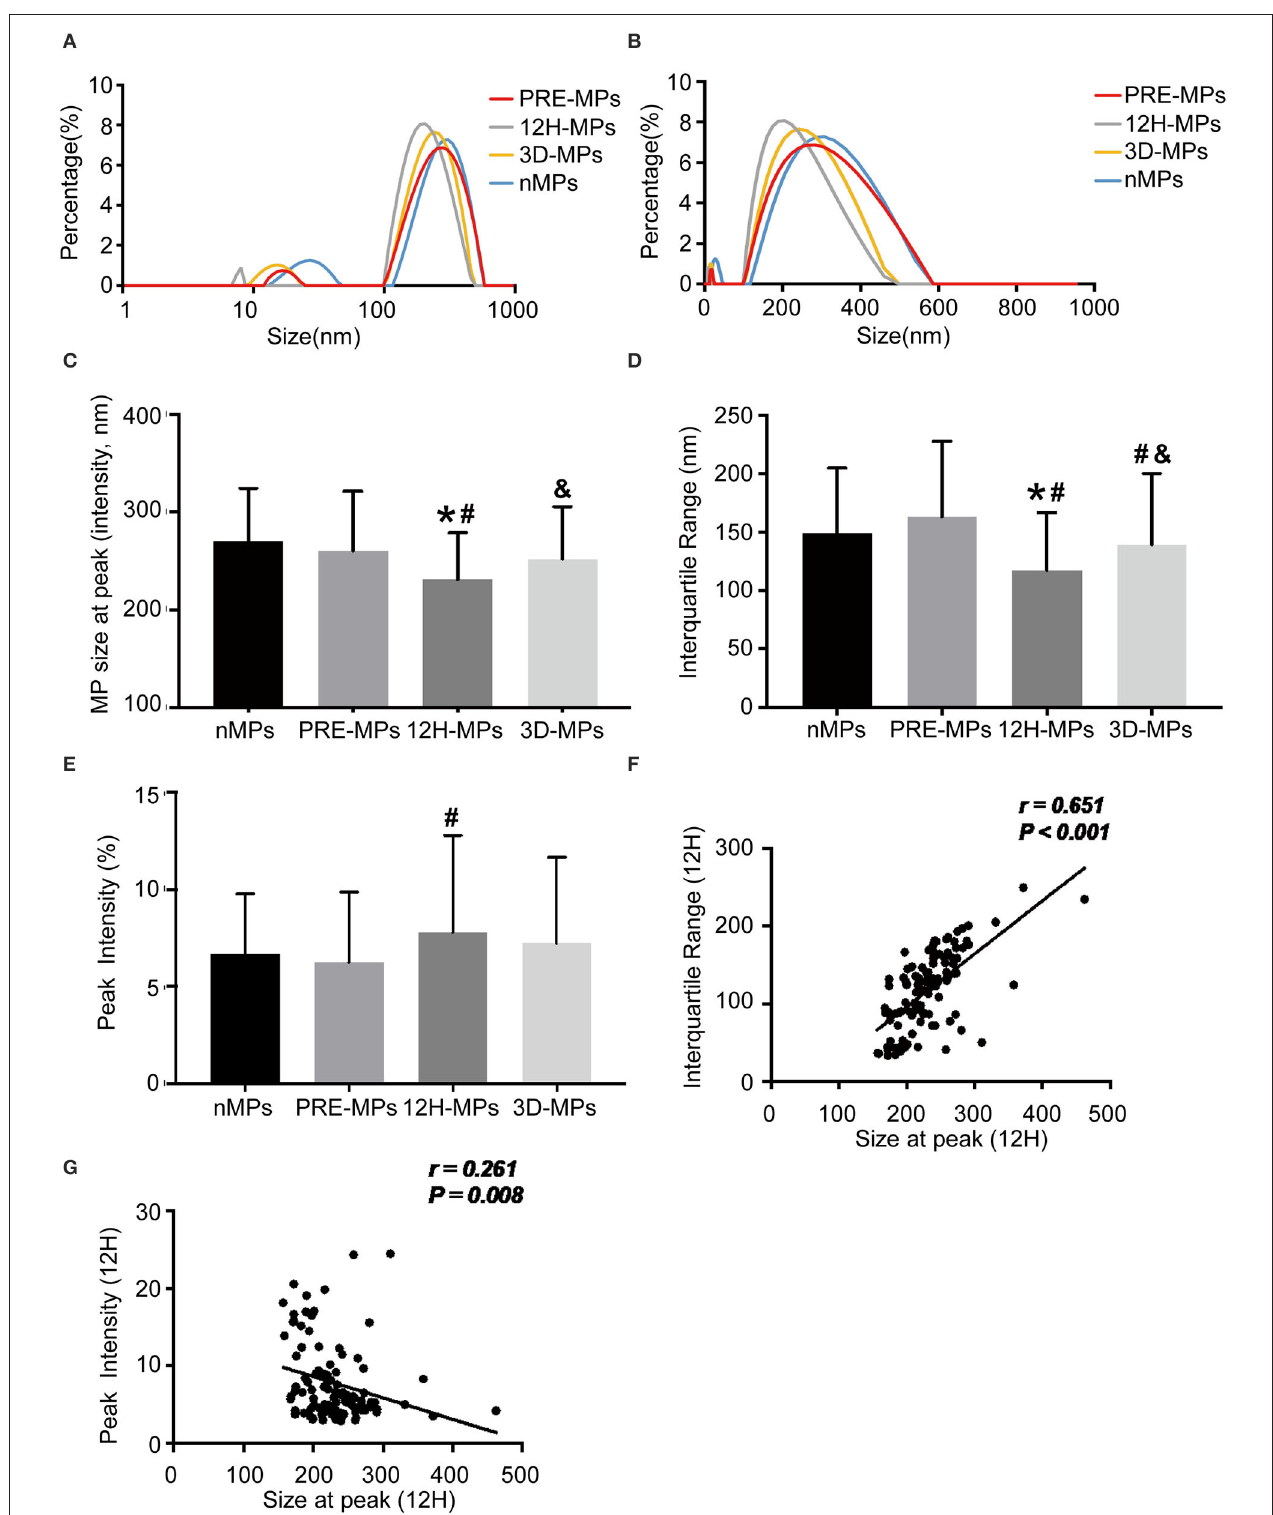
FIGURE 4 | The size distribution of microparticles (MPs) in patients and healthy subjects. (A,B) , Representative size distribution curve of MPs in patients (A,B) from the same patients using different X-axis. (C) The MPs size at peak between patients and healthy subjects. (D) The interquartile range (IQR) between patients and healthy subjects. (E) The peak intensity between patients and healthy subjects. (F) Correlation between size at peak and IQR at 12h after operation. (G) Correlation between size at peak and peak intensity at 12h after operation. *, vs. nMPs, P < 0.05; #, vs. PRE-MPs, P < 0.05; &, vs. 12H-MPs, P < 0.05. nMPs, MPs from healthy subjects; PRE-MPs, MPs from pre-operation; 12H-MPs, MPs from 12h after operation; 3D-MPs, MPs from 3 d after operation; 12H, 12h after operation.